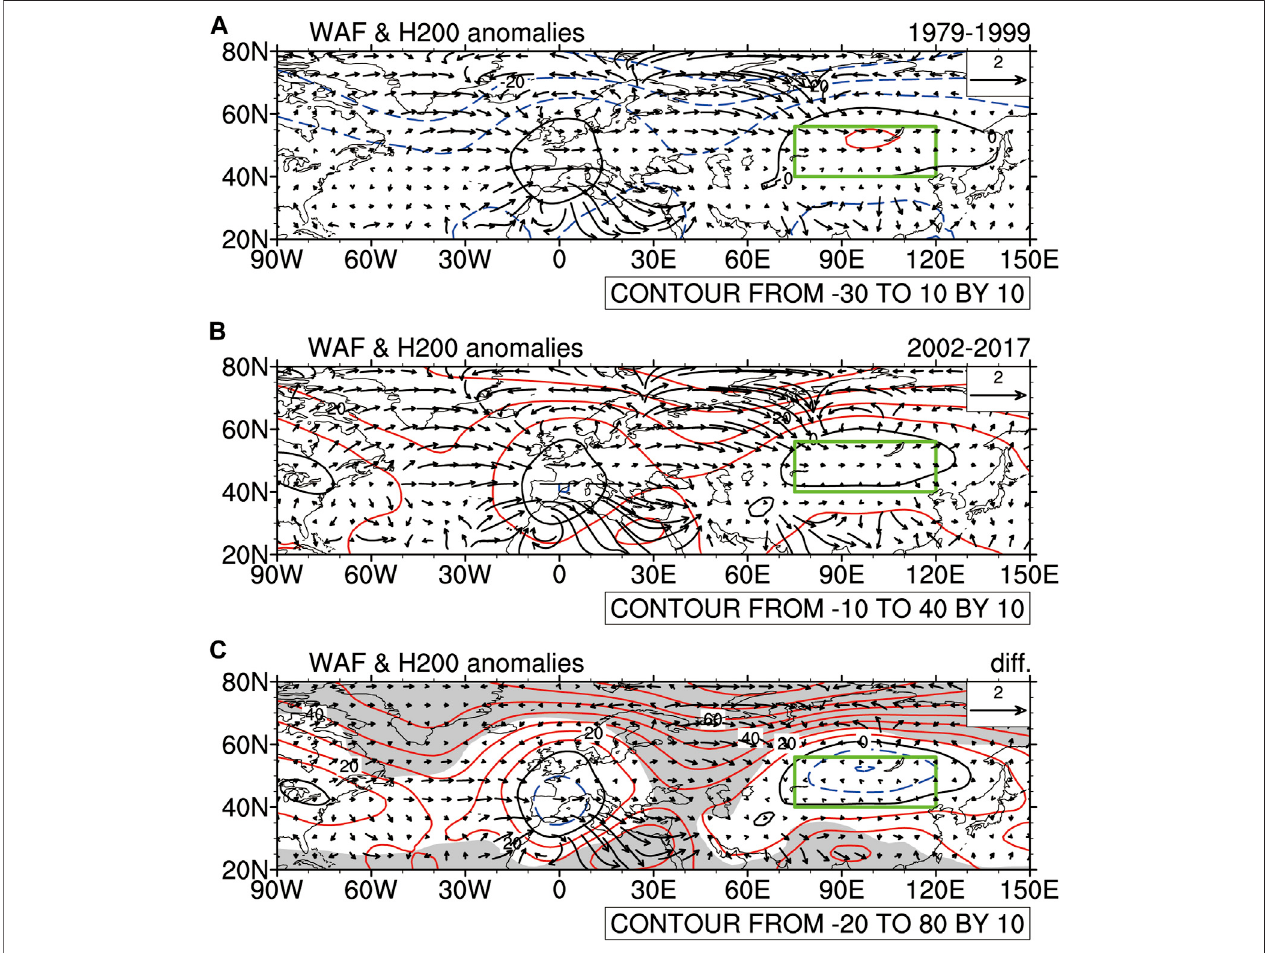
FIGURE7|(A, B,C) Theanomalies oftheRossbywaveactivity fl uxes(vectors; units:m 2 s − 2 )andgeopotentialheight(contours;units: gpm)at200 hPaduring (A) 1979 – 1999 and (B) 2002 – 2017, and (C) their difference (2002 – 2017 minus 1979 – 1999). Anomalies are calculated based on the climatology of 1979 – 2017. The green frame denotes the location of the study area (40 ° – 56 ° N, 75 ° – 120 ° E). The shaded areas in (C) indicate statistical signi fi cance at the 95% con fi dence level based on the Student ’ s t